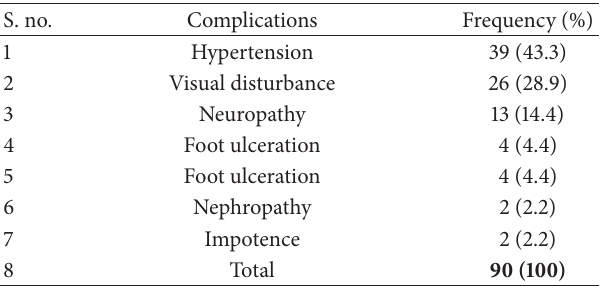
Table 4: Distribution of chronic diabetic complications in Dessie Referral Hospital, April–June, 2013. S.